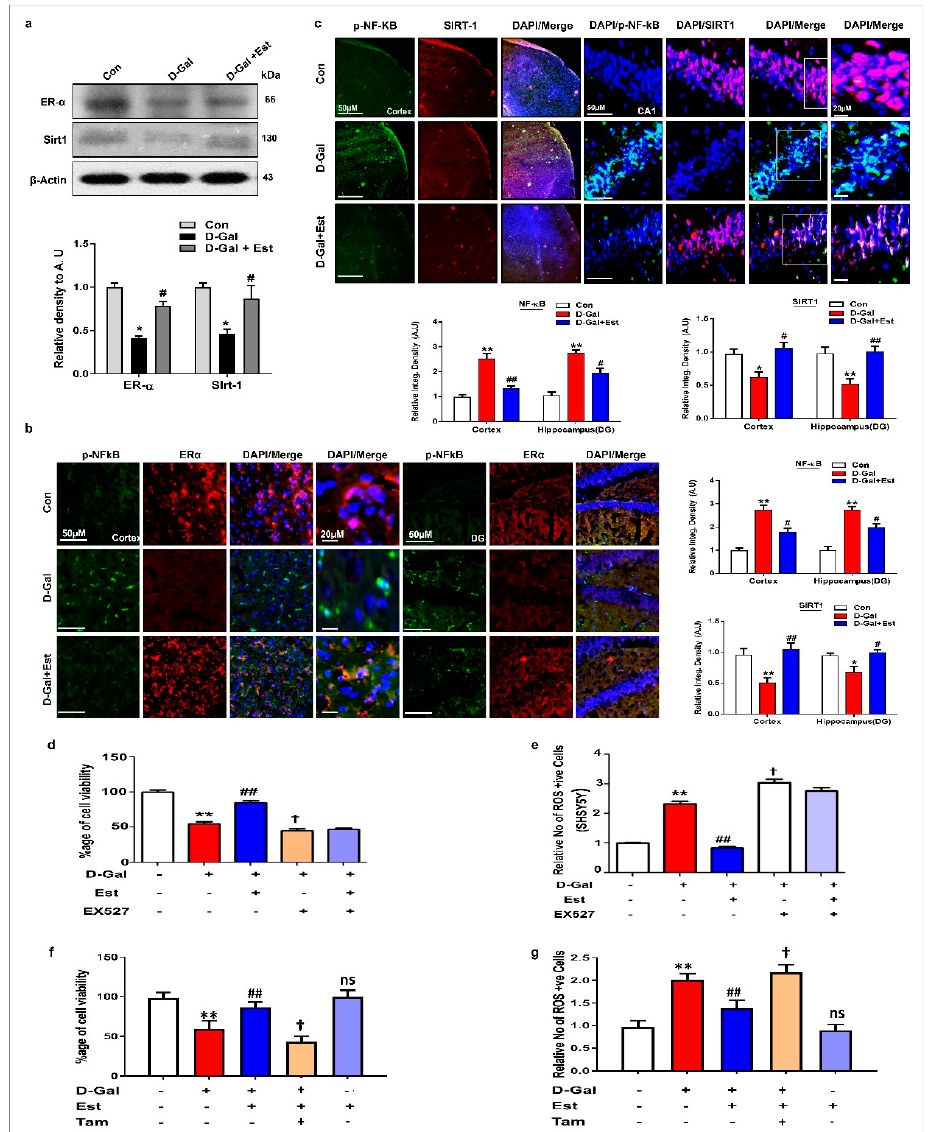
Figure 4. 17 β -estradiol stimulate estrogen receptor alpha (ER- α )/sirtuin 1 (SIRT1) signaling in D -gal treated mice and in vitro. ( a ) Shown are the western blot analysis of ER- α and SIRT1 in the adult mice brain homogenates of all three experimental groups. β -actin was used as a loading control. For protein band quantification ImageJ software was used. The density values were expressed in arbitrary units (AUs) as the mean ± SEM. ( b , c ) Given are the representative images of double immunofluorescence staining of ER- α , p-NF-kB and SIRT1 and in the hippocampal and cortical regions of the treated mice (n = 7–8 mice/group). The values represent averages from three independent experiments. For